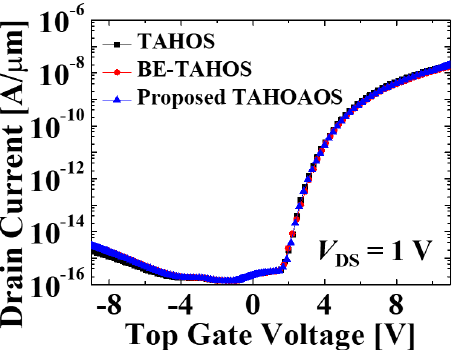
Figure 3. Basic transfer characteristics of three different device structures. These transfer character- istics show that our simulation is well designed with the same EOT thickness. Second, the bottom gate was added to suppress programming of the unselected cell and solve disturbance issues [37]. Specifically, as illustrated in Figure 4, the additional bottom gates are connected with each other by the bottom gate line, which is perpendic- ular to the source line and word line. From this perpendicular design between the bottom gate line and word line, it is possible to program the selected cell only and inhibit pro- gramming of unselected cells, as described in the following paragraph.